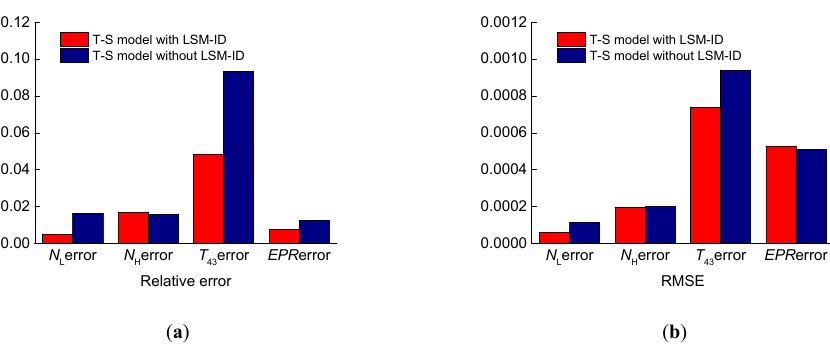
Figure 8. Relative error and RMSE compared with the nonlinear model under 1 km and 0.15 Ma. ( a ) Relative error comparison. ( b ) RMSE comparison.